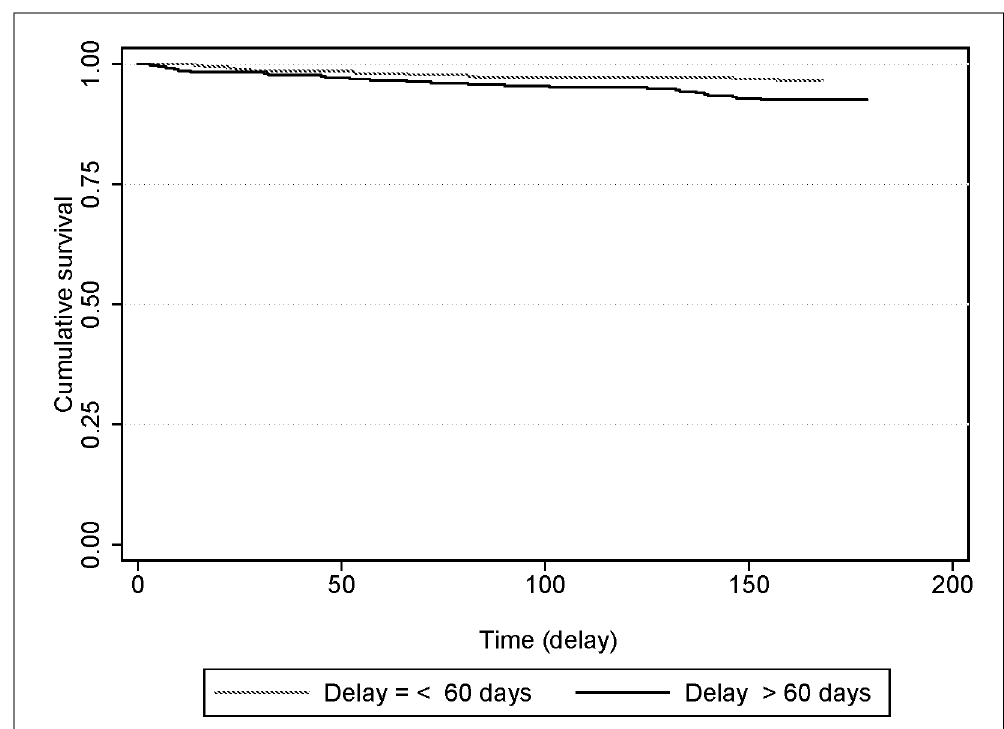
Fig 2. Kaplan-Meier estimate survival curves showing unfavorable treatment outcome of new PTB patients by total delay status.